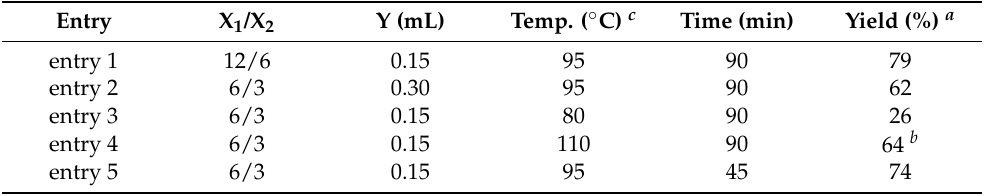
Table 2. Optimization of reaction conditions.